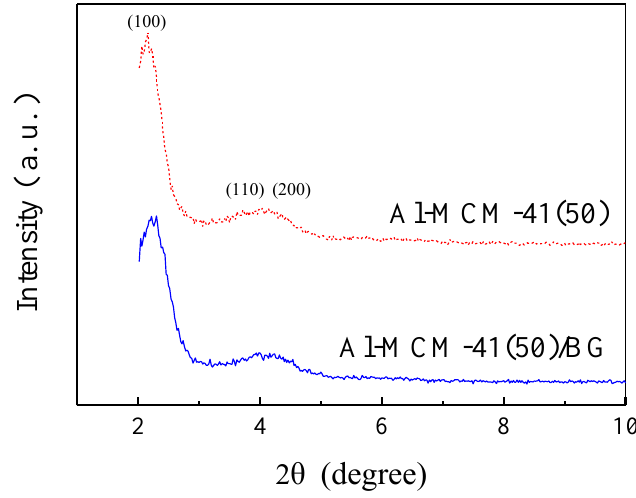
Figure 2. Powder X-ray diffraction pattern of Al-MCM-41(50) and dye impregnated